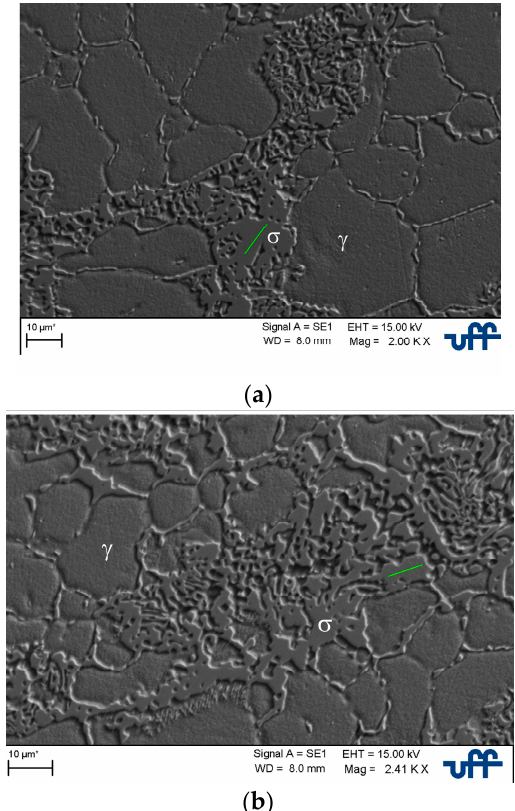
Figure 9. ( a , b ) Micrographs of the sample treated at 800 °C for 108,000 s (30 h), presenting austenite ( γ ) and sigma ( σ ) at different positions of the sample. The green line shows the position of the line of energy dispersive spectrometry (EDS) scanning.